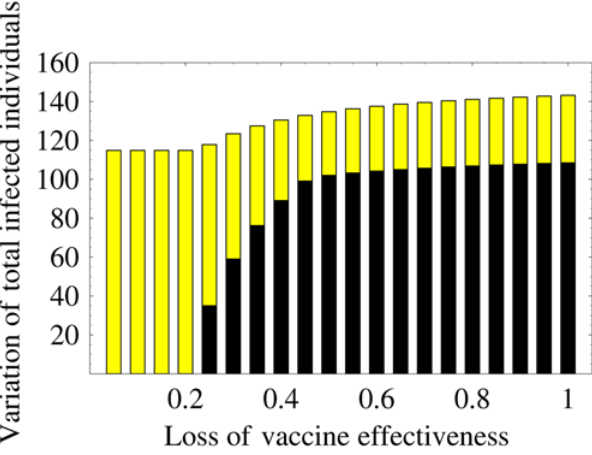
Figure 5. Variation of the final size of the epidemic over the vaccination prevalence: The black bar represents the optimal (smallest) final size of the epidemic. The yellow bar represents the worst (largest) final size of the epidemic over the vaccination prevalence. The variation of the final size depending on the prevalence rate is between black and yellow bars. If the loss of protection effectiveness is small, then the variation is very large. On the other hand, if the loss becomes large, then the variation decreases. Therefore, the final size of the epidemic is strongly affected by the vaccination coverage and the loss of protection effectiveness: a bad vaccination program (far from the optimal prevalence rate) increases the final size and prevents eradication of the disease.